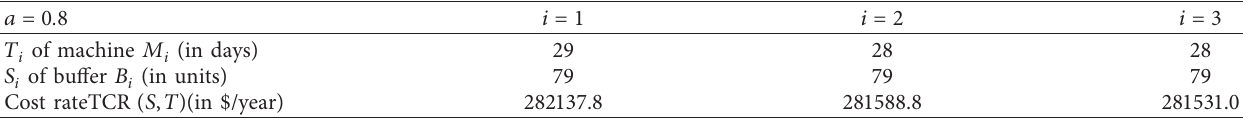
Table 7: The lowest cost rate with the optimal monitoring time of the machine of the intelligent series system and the optimal buffer stock with different a .